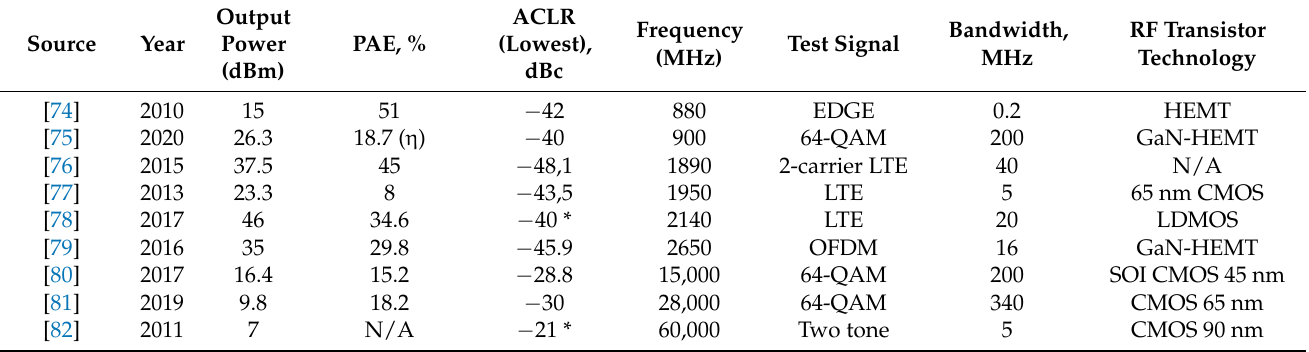
Table 3. Predistortion results.